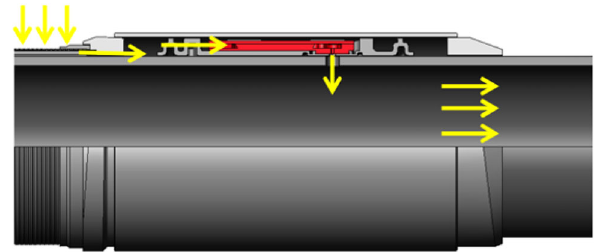
Fig. 4 a Photograph of a fluidic diode unit with credit card for size reference and b the housing subassembly securing a fluidic diode unit to the production joint